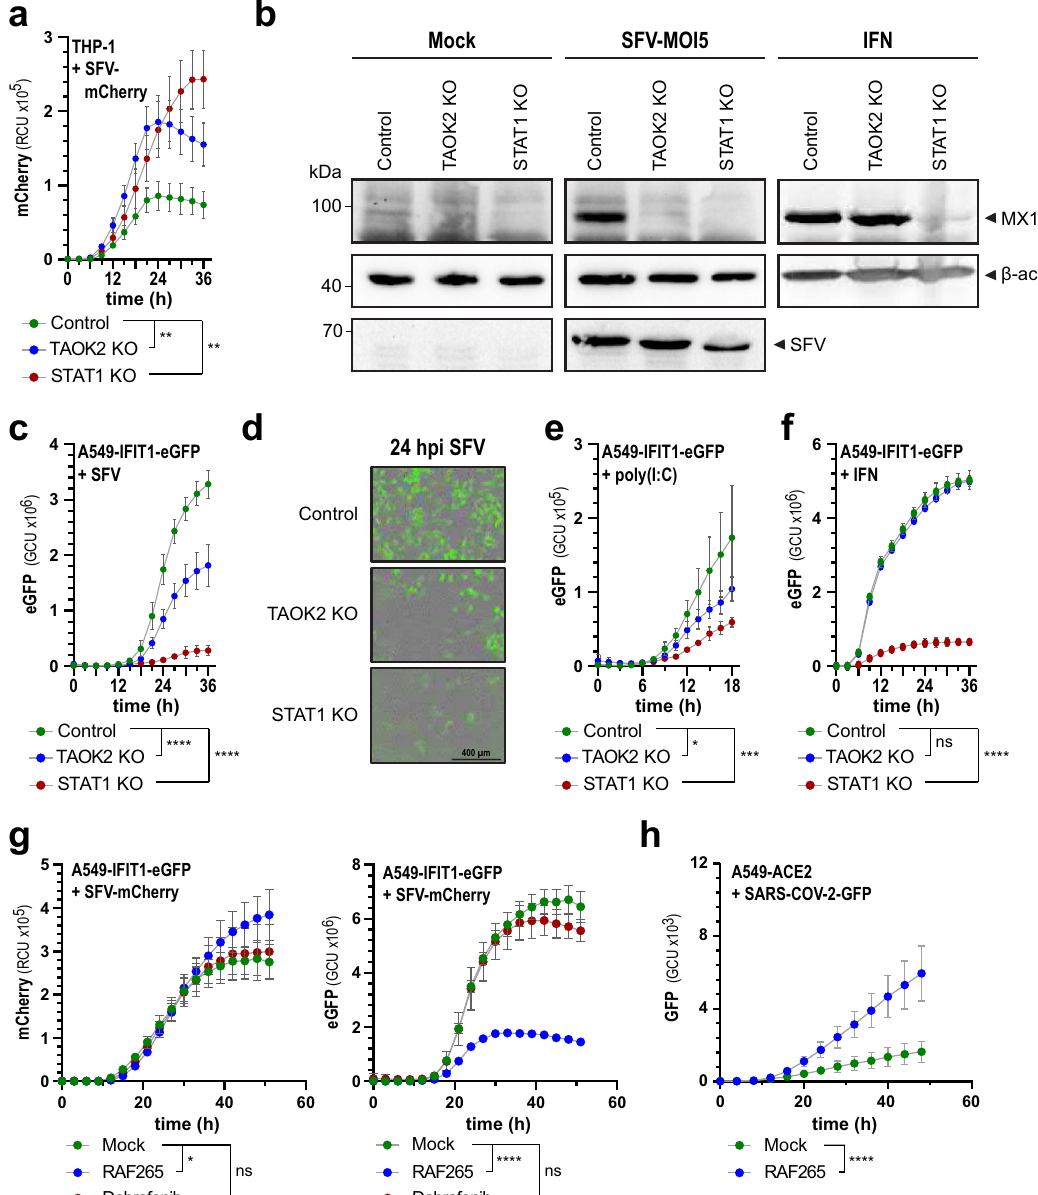
Fig. 6 TAOK2 is required for IFN induction in infected and poly(I:C) stimulated cells. a THP-1 cells were infected with SFV-mCherry (MOI 5) and red fl uorescence intensity was measured every 3 h using an Incucyte S3 live-cell imaging system. The line diagrams show the mean integrated red intensity/ cell con fl uence per image (RCU) ± SD ( y -axis) over time ( x -axis). b Nontargeted control (Control), TAOK2 KO, or STAT1 KO THP-1 cells were left unstimulated (Mock) or stimulated with SFV (MOI 5) or IFN- α B/D (1000 units/mL) for 24 h and used for western blotting against the indicated proteins. c Nontargeted control (Control), TAOK2 KO, or STAT1 KO A549-IFIT1-eGFP cells were infected with SFV (MOI 5) and green fl uorescence intensity was measured at the indicated time points using an Incucyte S3 live-cell imaging system. Mean green intensity/cell con fl uence per image (GCU) ± SD ( y -axis) is shown over time ( x -axis). d Representative fl uorescence microscopy images of (c) 24 h after infection with SFV. e , f as (c) but transfected with poly(I:C) (2 µ g/mL) ( e ) or stimulated with IFN- α B/D (1000 units/ml) ( f ). Control cells are colored in green, TAOK2 KO cells in blue, and STAT1 KO cells in red. g A549-IFIT1-eGFP cells were infected with SFV-mCherry (MOI 5) and simultaneously treated with the TAOK2 inhibitor RAF265 (500 nM, blue), BRAF inhibitor Dabrafenib (500 nM, red), or left untreated (green). Green (GCU) and red fl uorescence (RCU) intensities were measured at the indicated time points using an Incucyte S3 live-cell imaging system. Mean green or red intensity/cell con fl uence per image (G/RCU) ± SD ( y -axis) is shown over time ( x - axis). h A549-ACE2 cells were treated with the TAOK2 inhibitor RAF265 (10 µ M) and infected with SARS-COV-2-GFP (MOI 3) and accumulation of GFP was measured over time in an Incucyte S3 system. Line diagrams show the mean green intensity/cell con fl uence per image (GCU) ± SD ( y -axis) over time ( x -axis). Data presented in ( a – h ) is representative of three independent experiments and for each line diagram, the mean ± SD are plotted based on at least four biological repeats. **** p < 0.0001, *** p < 0.001, ** p < 0.01, * p < 0.05, ns p > 0.05 (Repeated measurements two-way ANOVA with Š ídák ’ s multiple comparison test to compare control versus treatment conditions). Source data are provided as a Source Data fi